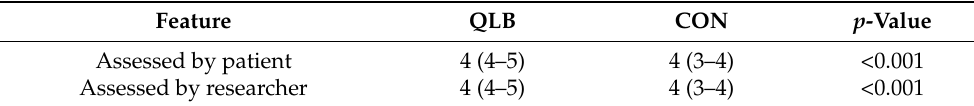
Table 3. Patient satisfaction with postoperative pain treatment.